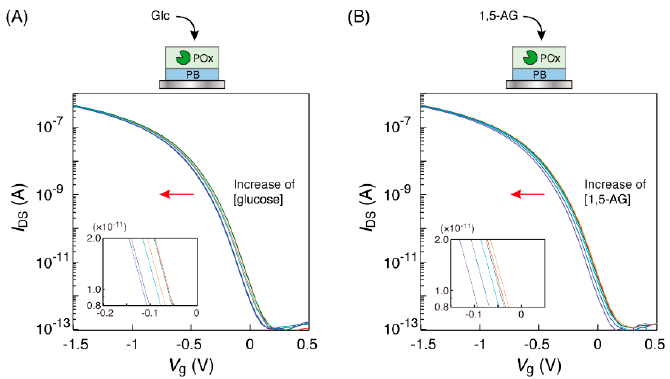
Figure 3. Transfer characteristic curves of the organic field-effect transistor (OFET) biosensor with a POx-PB electrode obtained in response to the electrode’s immersion into ( A ) glucose and ( B ) 1,5-AG solutions at different concentrations (0, 0.1, 0.5, 1, 3 and 10 mM), buffered by 1 ×PBS at 25 °C. Each concentration curve has been indicated in red (0 mM), orange (0.1 mM), green (0.5 mM), light blue (1 mM), blue (3 mM) and purple (10 mM), respectively. The insets show the enlarged views.